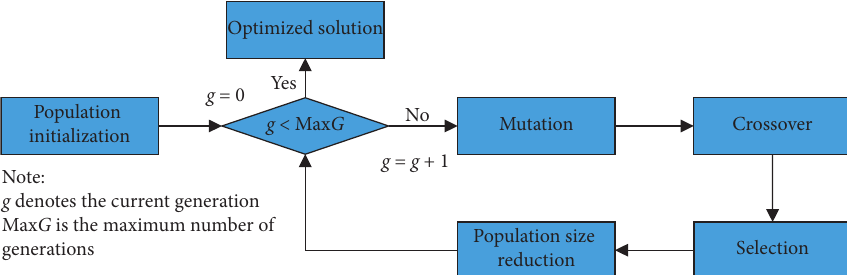
Figure 2: The operational flow of the L-SHADE algorithm.